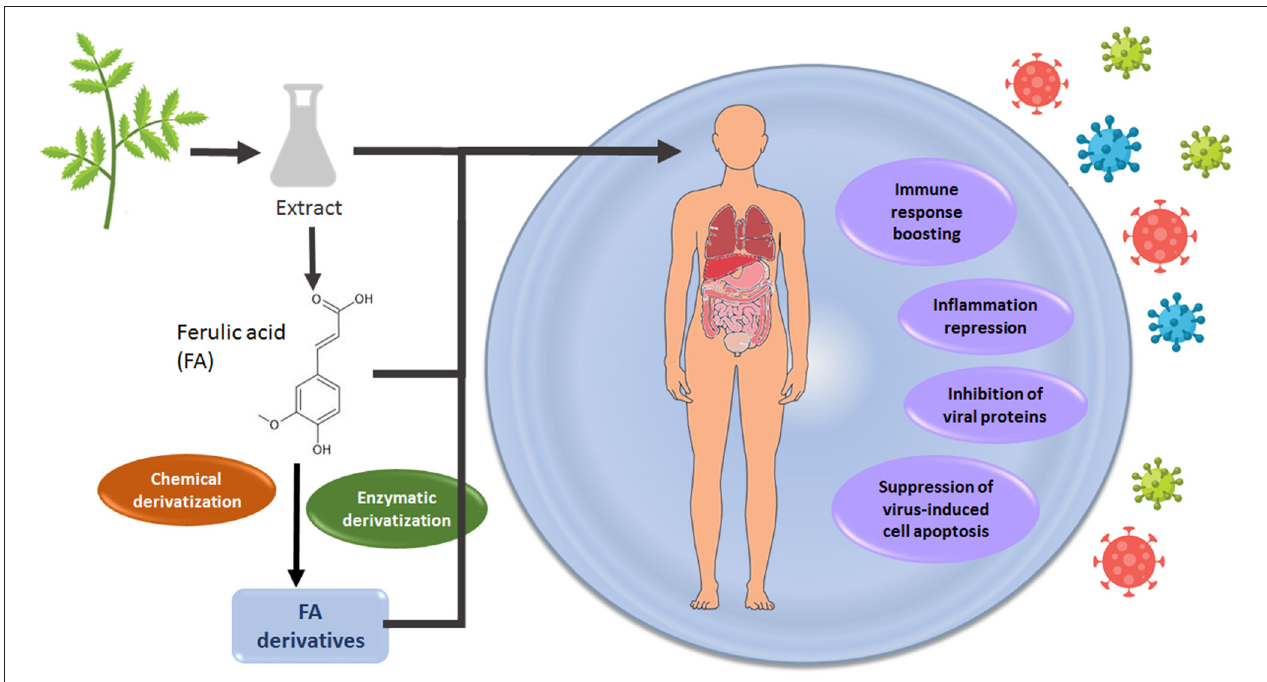
FIGURE 3 | A route for FA valorization toward developing antiviral